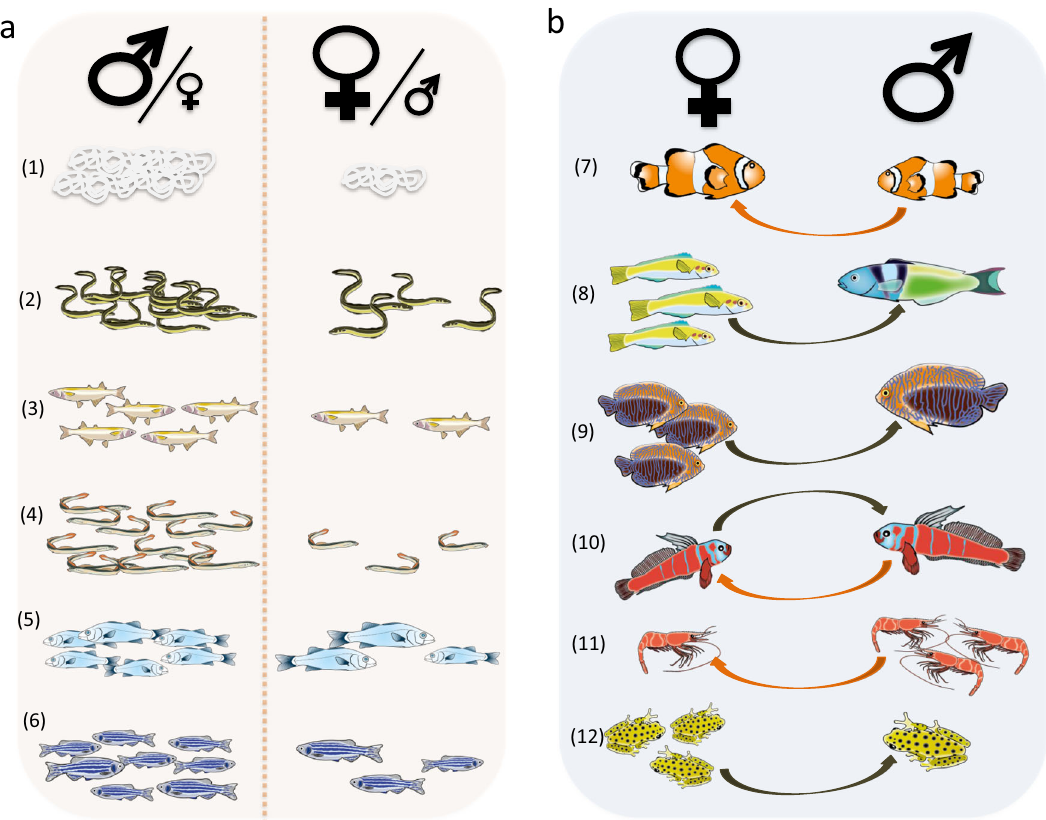
Fig. 3 Condition-dependent sex determination and sex change. a Density-dependent sex determination potentially affecting ASR in (1) the nematode Romanomermis culicivorax , (2) temperate eels, (3) the pejerrey, (4) the brook lamprey, (5) the European sea bass and (6) the zebra fi sh Danio rerio . In all the above-mentioned species, more males are produced at high density. b Socially induced sex change occurs in various species such as (7) protandrous clown fi shes, protogynous (8) wrasses (e.g., Thalassoma bifasciatum ) and (9) Potter ’ s angel fi sh as-well as bi-directional sex change as exempli fi ed in (10) the blue-banded goby. Other examples of socially controlled sex change were observed in both crustaceans and amphibians: (11) Northern shrimp exhibit protandrous sex change that occurs at small size when the density of females in the population is high. Protogynous sex change was also observed in (12) captive reed frogs and its occurrence is linked to local male density. Hence, for most sex changing species, those individuals that do not change sex are more numerous. Note that the direction of the arrow in the right panel ( b ) indicates the direction of sex change: orange from male to female (protandrous) and maroon from female to male (protogynous). Drawing by Pierre Lopez (MARBEC) based on data from refs. 71 – 82,169